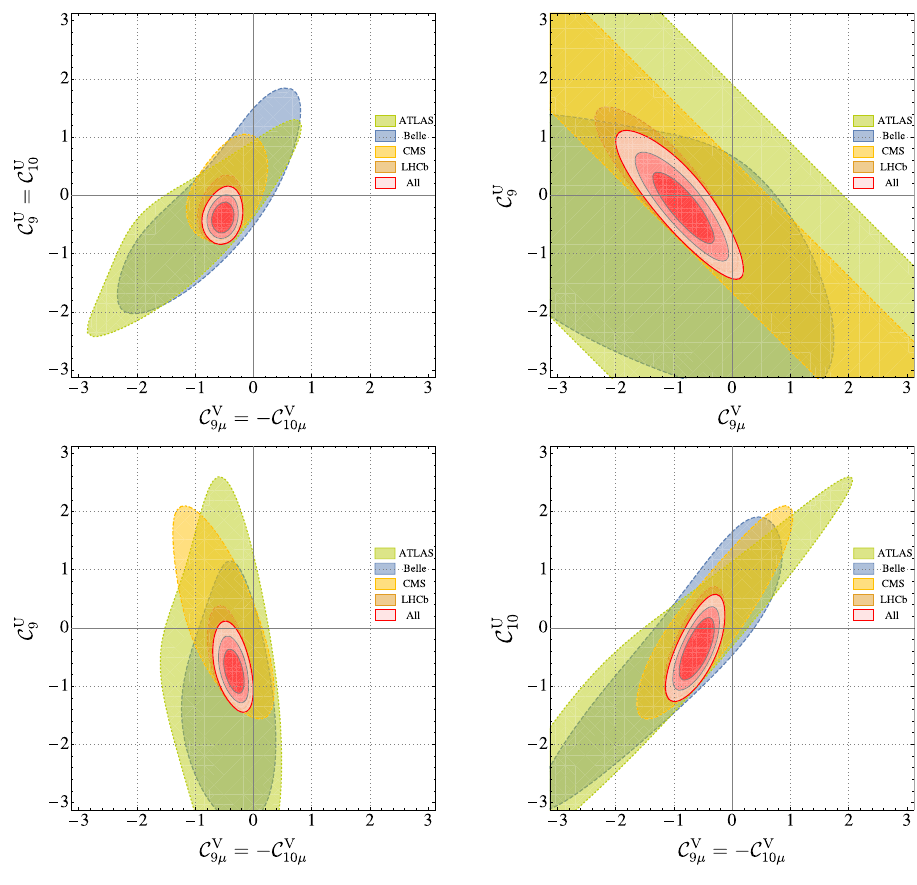
Fig. 3 Updated plots of Ref. [2] corresponding to scenarios 6, 7, 8 and the new scenario 9